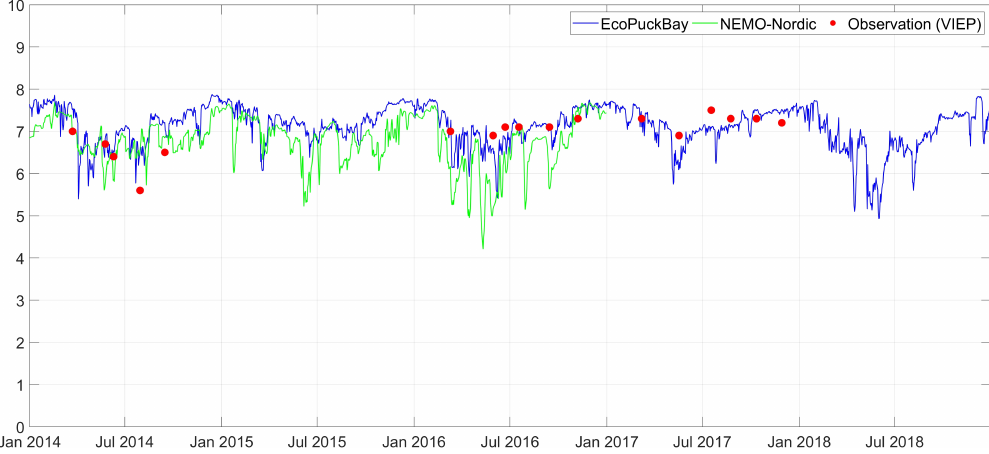
Figure A13. Time series of surface salinity on station T14 compared with VIEP observations and NEMO-Nordic